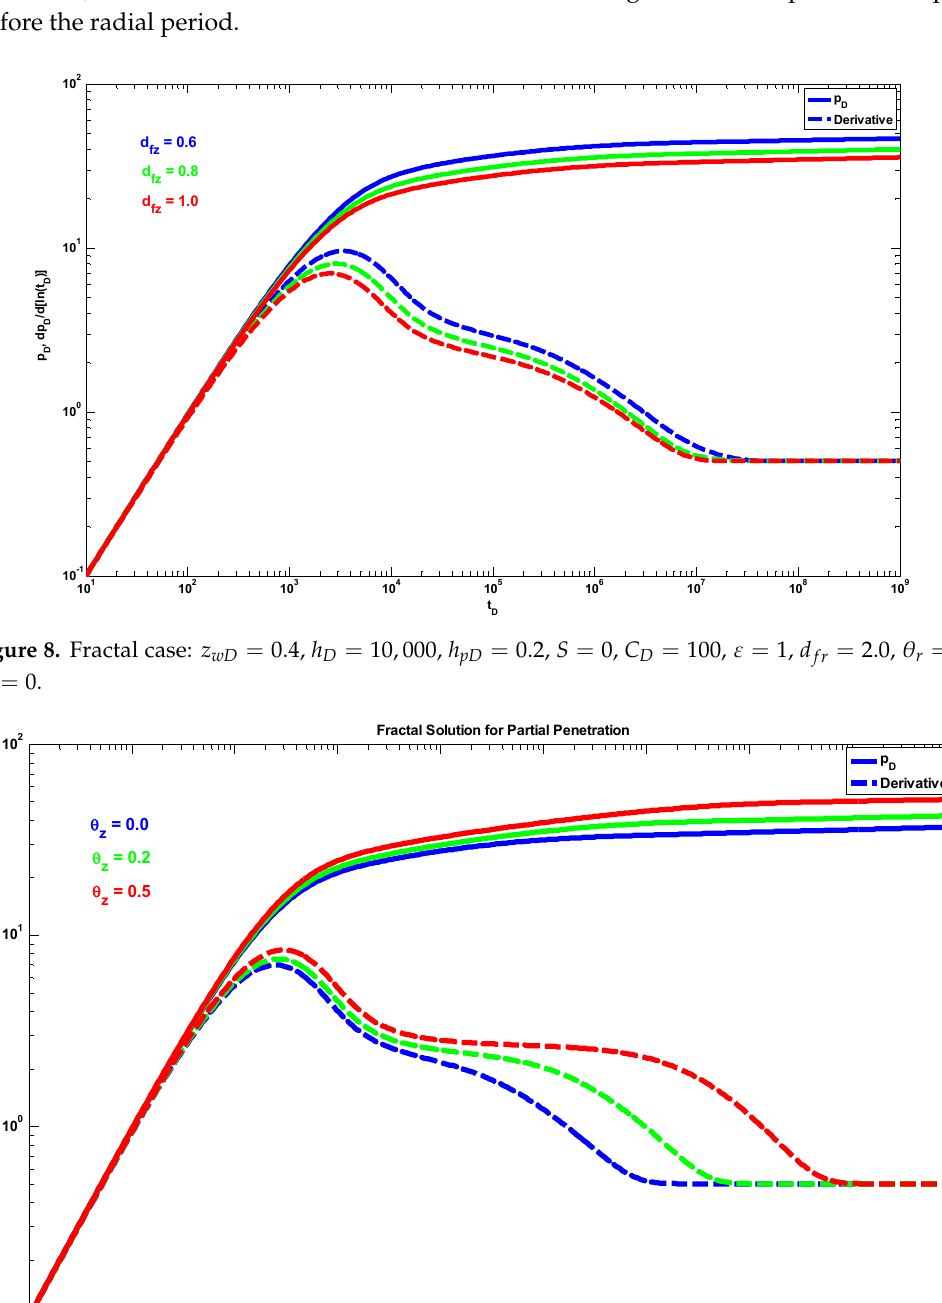
Figure 7. Fractal case: 𝑧 (cid:3050)(cid:3005) = 0.4 , ℎ (cid:3005) = 10000 , ℎ (cid:3043)(cid:3005) = 0.2 S = 0 , 𝐶 (cid:3005) = 100 , 𝜀 = 1 , 𝑑 (cid:3033)(cid:3045) = 2 , 𝑑 (cid:3033)(cid:3053) = 1 , 𝜃 (cid:3053) = 0.